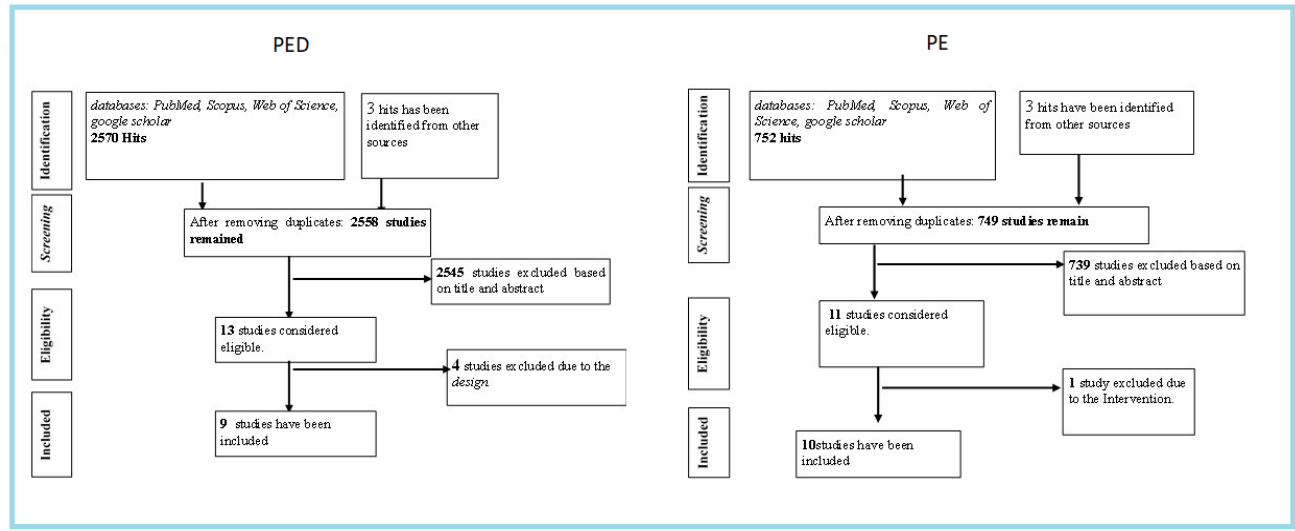
Figure 1. The figure depicts on the left side the flow chart of the selection process for PED studies and on the right side, the process for the PE studies.